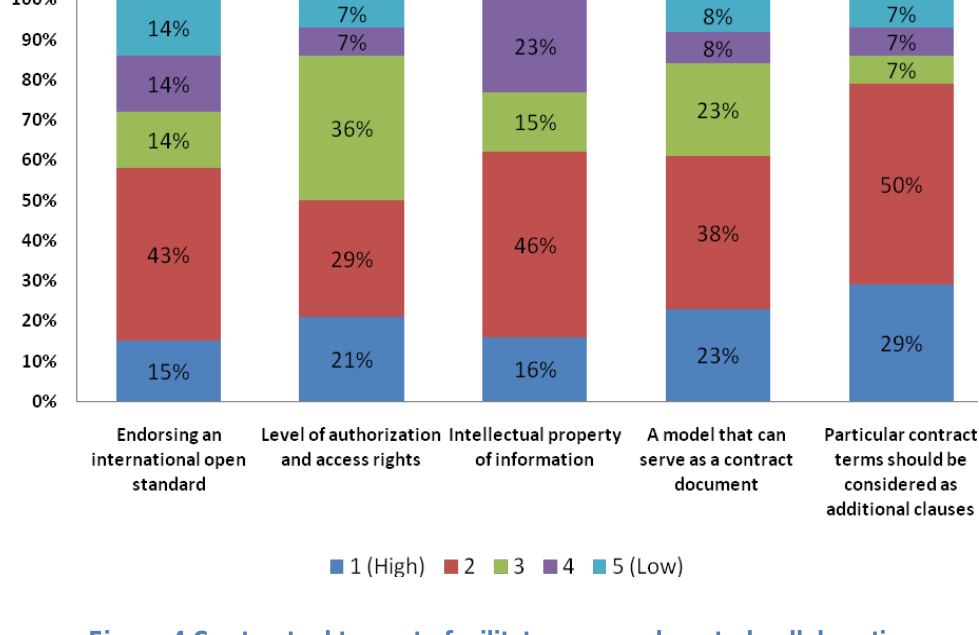
Figure 4 Contractual terms to facilitate open and neutral